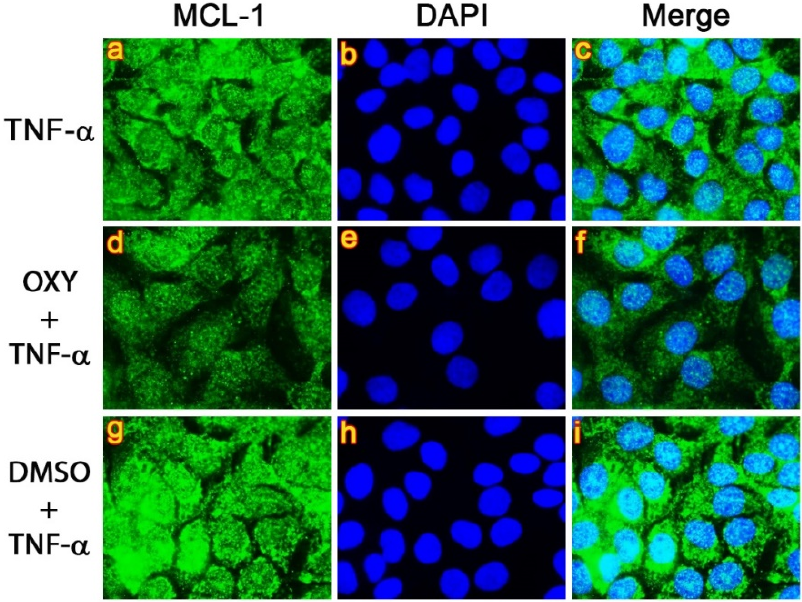
Figure 7. Inhibitory effects of OXY on TNF- α -stimulated expression of Ki-67 (green) in the nuclei of HaCaT cells. Nuclei were stained with DAPI (blue). Visualization was performed at 100 × magnification. Picture ( a – c ) present TNF- α -stimulated cells showing Ki-67 staining, DAPI staining, and the merged images, respectively. Picture ( d – f ) represent OXY-treated cells stimulated with TNF- α showing Ki-67 staining, DAPI staining, and the merged images, respectively. Picture ( g – i ) represent DMSO-treated cells stimulated with TNF- α showing Ki-67 staining, DAPI staining, and the merged images, respectively.